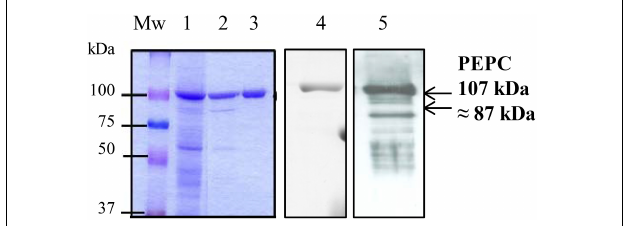
FIGURE 3 | SDS–PAGE analysis of the sp-PEPC fraction during the purification process. PEPC (0.2 U) from the different purification steps were subjected to SDS–PAGE and staining with Commassie blue. Lane 1, clarified protein extract from dark-adapted sorghum leaves; Lanes 2, 3, chromatografhy on Hydroxyapatite and on anion-exchange, respectively. Lane 3 correspond to the final sp-PEPC preparation mainly used in the experiments. Lanes 1–3 contain 0.2 U of PEPC). Lane 4, immunoblot of lane 3 (0.05 U PEPC) detected using PEPC-IgG. Lane 5, immunoblot of sp-PEPC (0.1 U PEPC) following 3 months at –20 ◦